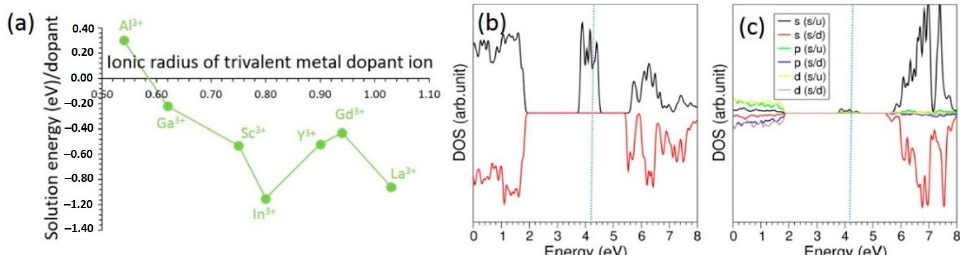
Figure 6. ( a ) Solution energies of trivalent dopants on the V site, ( b ) total DOS plot of In-substituted Zn 3 V 4 (PO 4 ) 6 , and ( c ) DOS plot associated with the In.